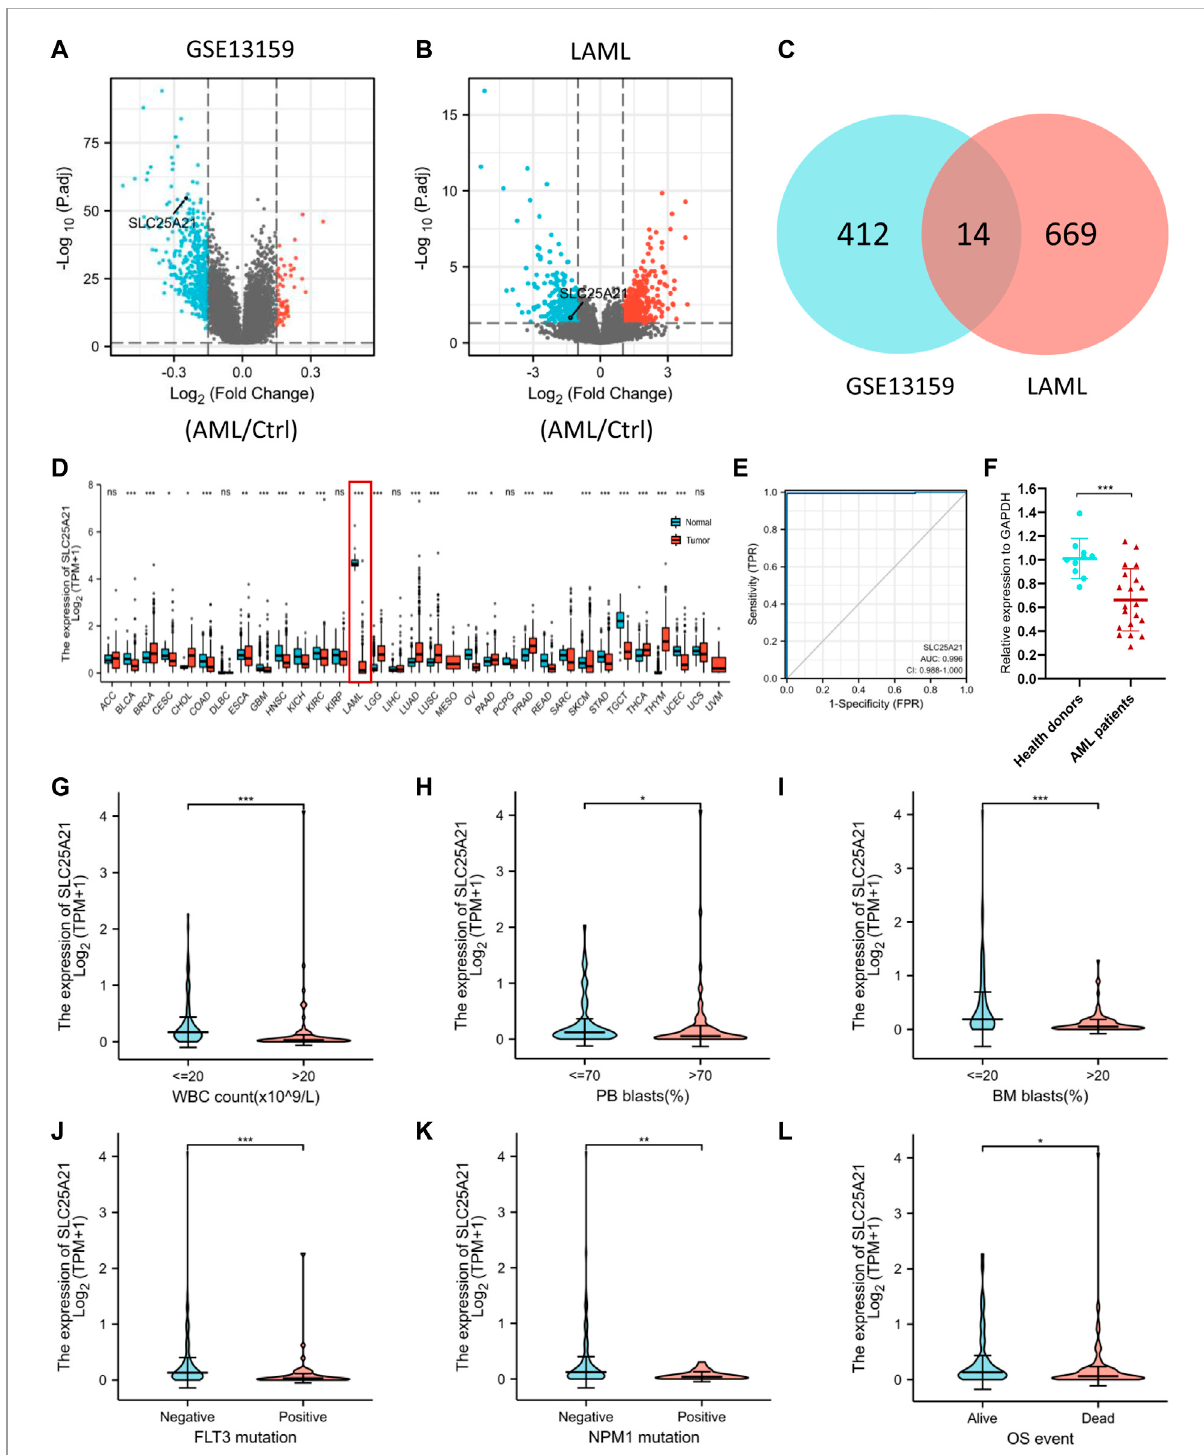
FIGURE 2 Identifying AML-speci fi c genes and the association of SLC25A21 expression with clinical characteristics. (A) Volcano plot displaying DEGs betweenAMLandcontrolbonemarrowsamplesintheGSE13159dataset.Eachpointrepresentstheaveragevalueofonetranscript. (B) Volcanoplot of DEGs between AML and normal samples in the TCGA-LAML and GTEx datasets. (C) Venn diagram of differential gene expression. Selected genes for further analysis based on theintersections of DEGs. (D) The level ofSLC25A21 expression indifferent tumor from TCGA and GTEx database. (E) Receiver operating characteristic (ROC) analysis of SLC25A21 in AML. The analysis was performed with the TCGA-LAML and GTEx dataset. (F)